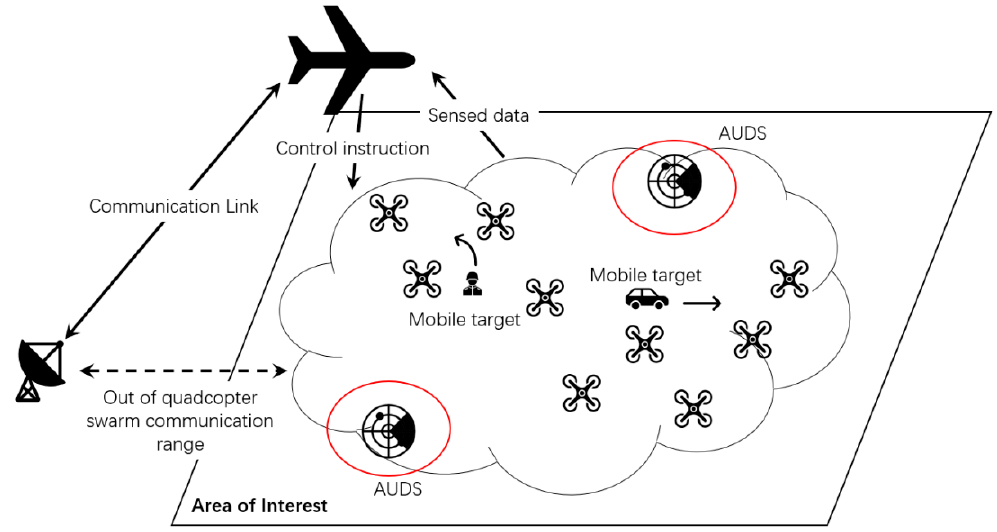
Figure 1. Hierarchical structure of proposed FANET persistent surveillance system.